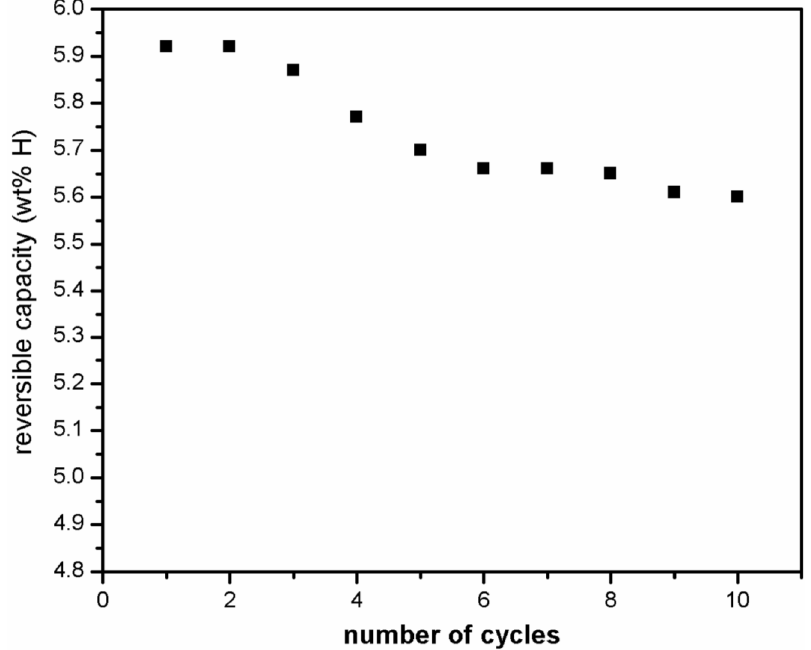
Figure 9. Hydrogen absorption kinetics at 310 °C under 1000 kPa of hydrogen of ball milled MgH 2 + 5 mol % MgF 2 for 10 cycles.